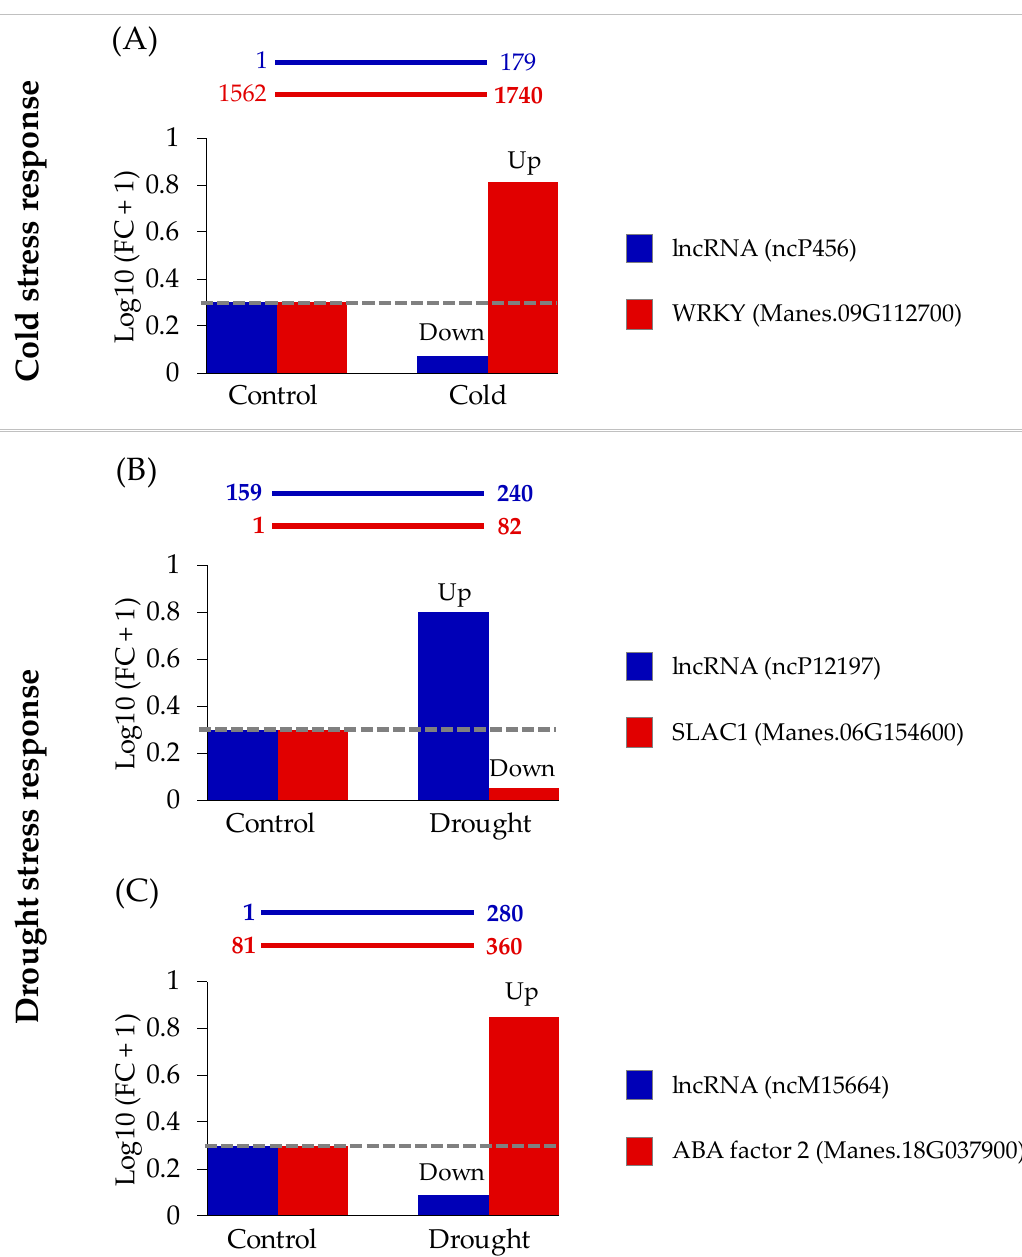
Figure 7. Potential novel lncRNAs that responded to cold and drought stress by a trans -regulatory relationship through direct binding to mRNAs of target genes. ( A ) Binding region of lncRNA ncP456 at position 1–179 and mRNA of target gene encoding WRKY DNA-binding protein 33 (Manes.09G112700) at position 1562–1740, including their fold change (FC) under control and cold conditions. ( B ) Binding region of lncRNA ncP12192 at position 159–240 and mRNA of target gene encoding SLAC1 (Manes.06G154600) at position 1–82, including their fold change (FC) under control and drought conditions. ( C ) Binding region of lncRNA ncM15664 at position 1–280 and mRNA of target gene encoding ABA responsive elements-binding factor2 (Manes.18G037900) at position 81–360, including their fold change (FC) under control and drought conditions. FC control = Expression control /Expression control ; FC cold = Expression cold /Expression control ; FC drought = Expression drought /Expression control.